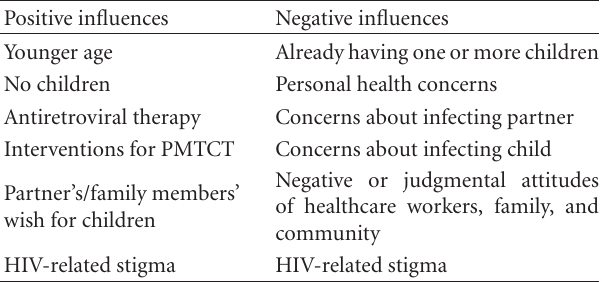
Table 1: Factors associated with fertility desires and intentions in women living with